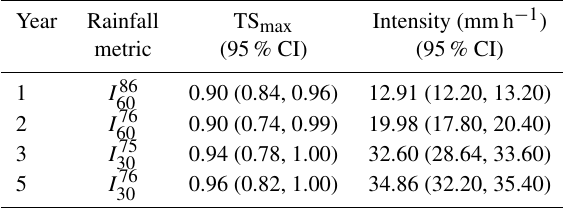
in each year with dif- 30